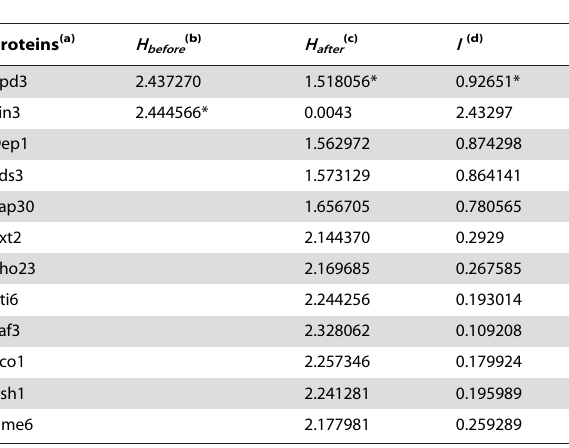
Table 1. Quantitative evaluation of the effect of the systematic deletion of subunits on the RPD3 complexes using Information Theory based